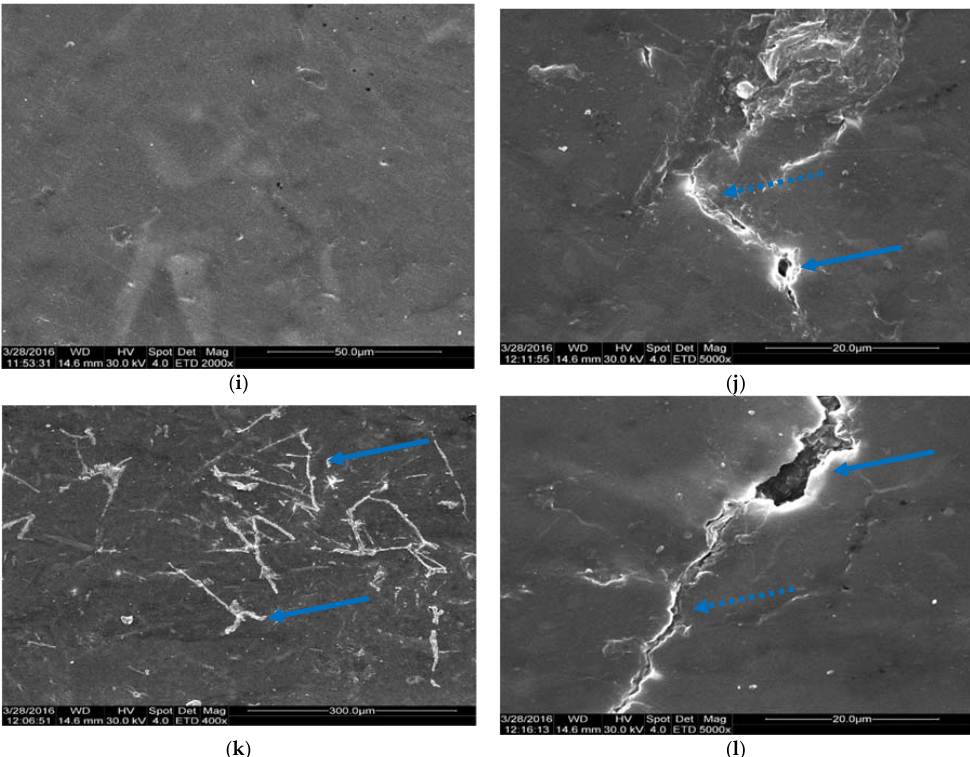
Figure 3. SEM images of the vPP ‐ cellulose composites’ surface biodegradation. ( a ) vPP before soil burial (2000×), ( b ) vPP after soil burial (arrow—damages extended on surface; 1000×), ( c ) vPP 20cell before soil burial 1000×), ( d ) vPP 20cell after soil burial (arrow—void; dotted arrow—surface exfoliation; 2000×), ( e ) vPP 30cell before soil burial (1000×), ( f ) vPP 30cell after soil burial (arrow—deep and extended fracture; 2000×), ( g ) vPP 30cell after soil burial network of flattened hyphae on material surface; 2000×), ( h ) vPP 30cell after soil burial (arrow—void; dotted arrow ‐ surface fracture and exfoliation; 2000×), (i) vPP 40cell before soil burial (2000×), ( j ) vPP 40cell after soil burial (arrow—void; dotted arrow— fracture; 5000x), ( k ) vPP 40cell after soil burial (arrow—flattened hyphae network, 400×), and ( l ) vPP 40cell after soil burial (arrow—deep crater; dotted arrow—surface fracture; 5000×).